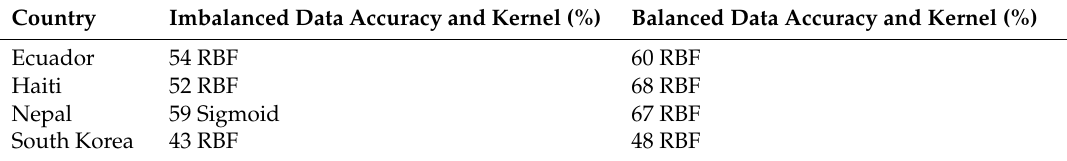
Table 9. Model accuracy with and without imbalanced data. Country Imbalanced Data Accuracy and Kernel